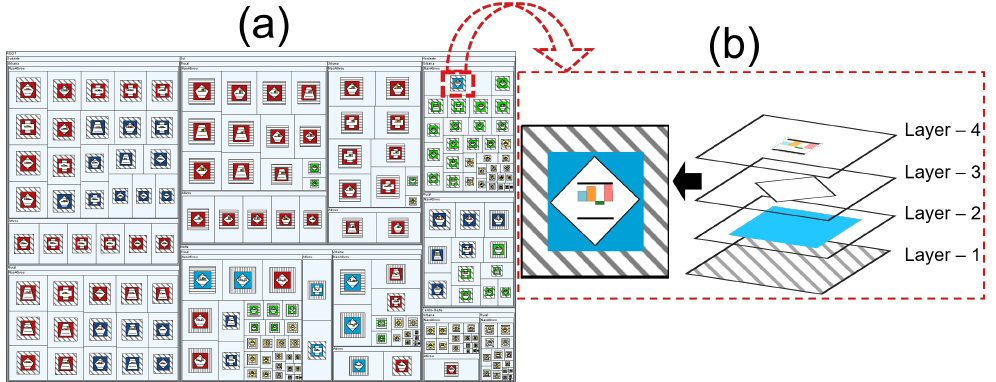
Figure 1. ( a ) A squarified Treemap with layered glyphs and ( b ) The adopted design strategy for the creation of layered glyphs, using overlapping layers, with each layer encoding a visual variable. The hierarchy of the Treemap maps three categorical dimensions, while the item’s size maps a quantitative one. The layers 1, 2 and 3 map a single categorical or ordinal dimension each, and layer 4 is a profile glyph that can map up to eight quantitative